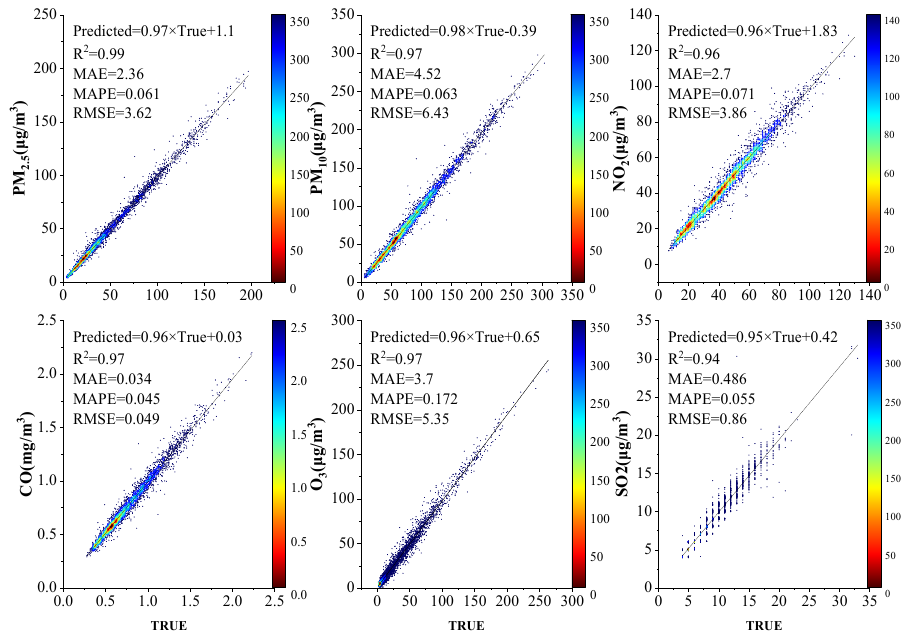
Figure 12. Comparison of actual and predicted values with meteorological factors.